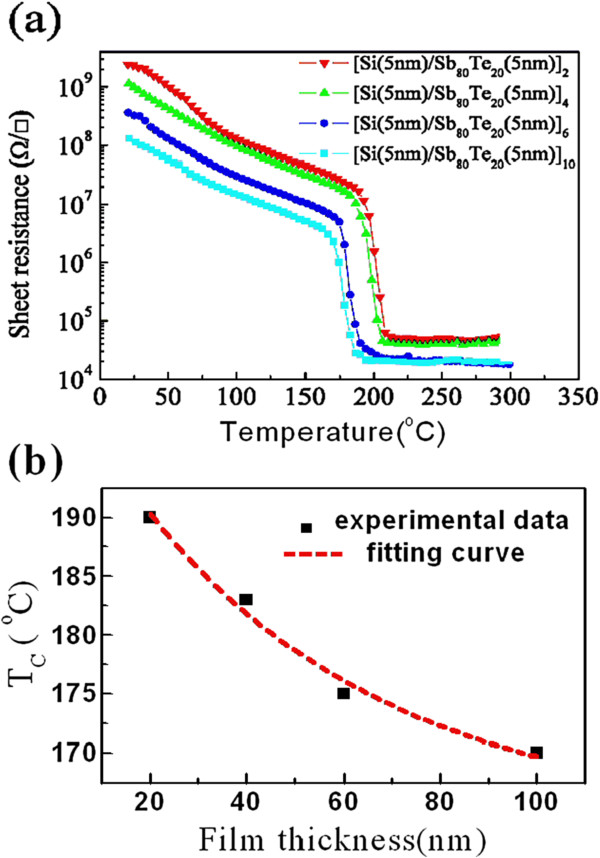
Temperature dependence of sheet resistance of [Si/Sb80Te20]xfilms. (a). The crystallization temperature decreases with the increase of the periodic number. (b) Crystallization temperature as an exponential function of the total thickness of [Si/Sb80Te20]x films.